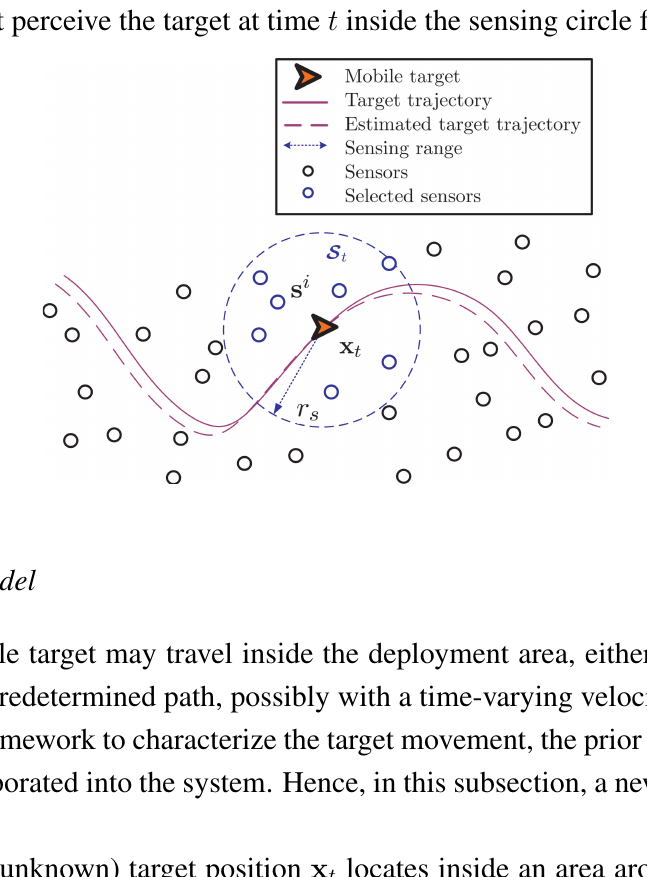
Figure 1. Illustration of the sensors deployment and the mobile target moving. Herein, the dotted circle denotes the sensing range within which the sensors can sense the target, and all of these nodes that perceive the target at time t inside the sensing circle form the cluster S